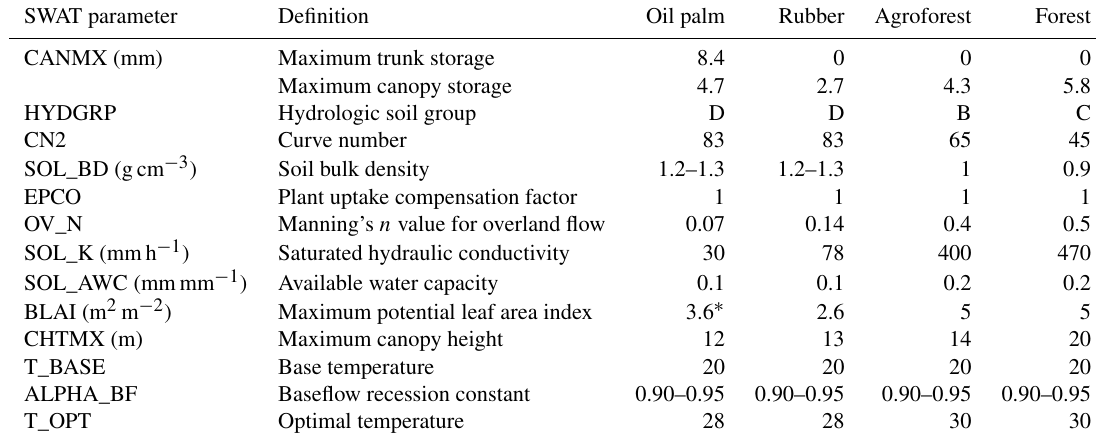
Table 2. Adapted parameter inputs for the study area. SWAT parameter